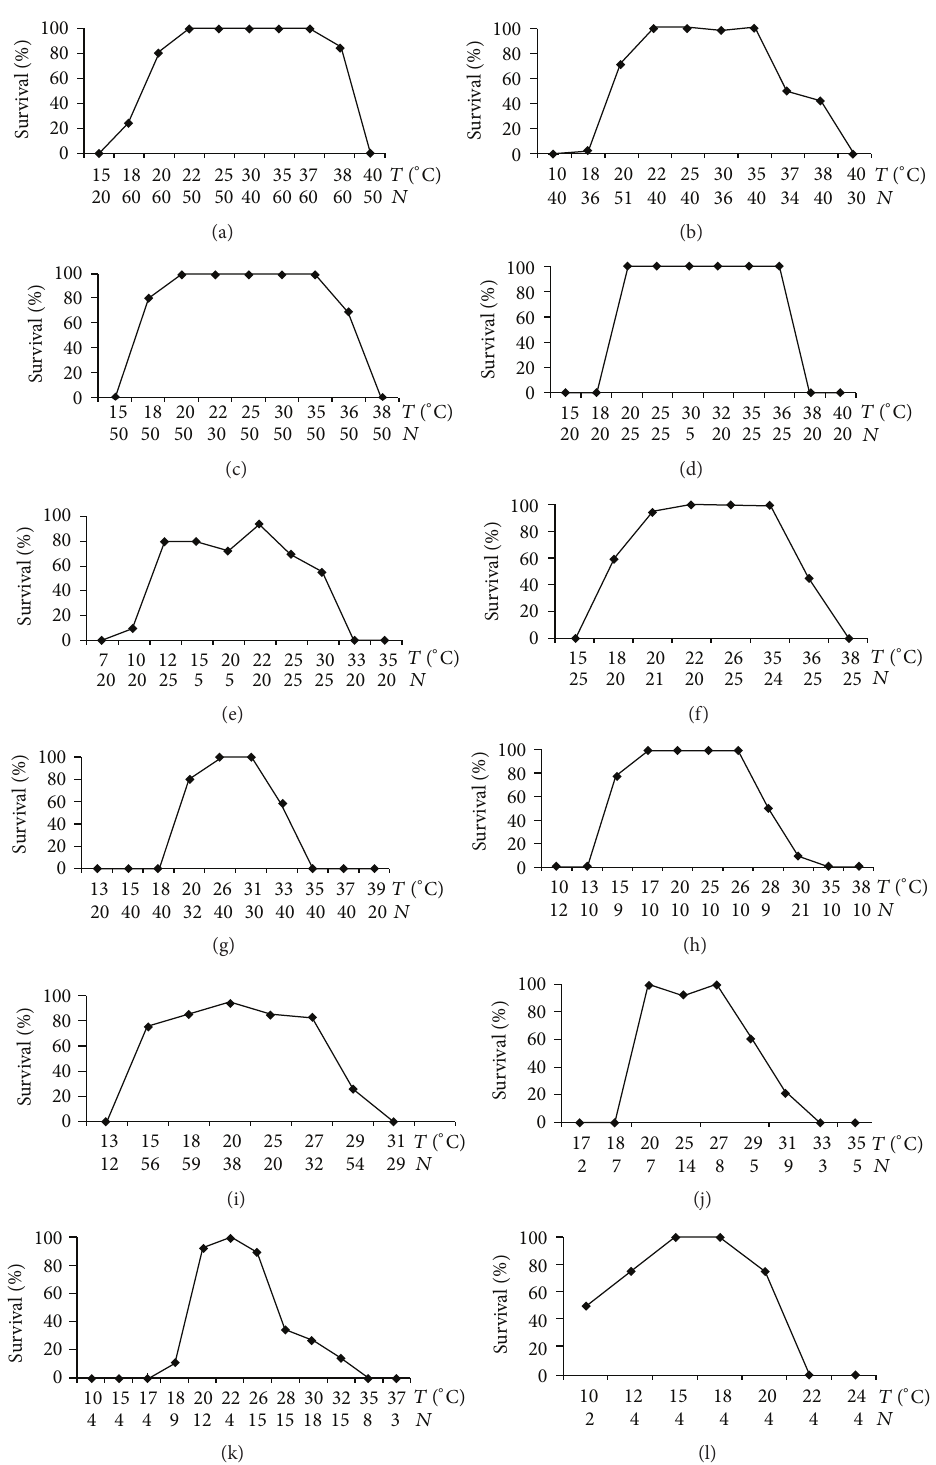
Figure 1: Thermal tolerances in anuran embryos. N: number of embryos per each experimental temperature ( ∘ C). (a) R. humboldti; (b) R. marina; (c) H. crepitans; (d) D. microcephalus; (e) D. labialis ; (f) E. pustulosus ; (g) L. insularum ; (h) E. prosoblepon ; (i) S. punctulata ; (j) D. truncatus ; (k) E. johnstonei ; (l) P. uranobates